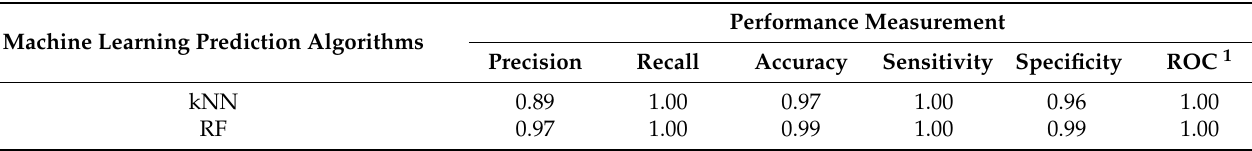
Table 1. Performance measurement of kNN and RF-based TIP predictors on the test dataset evaluated by the confusionMatrix() function of the caret R package.